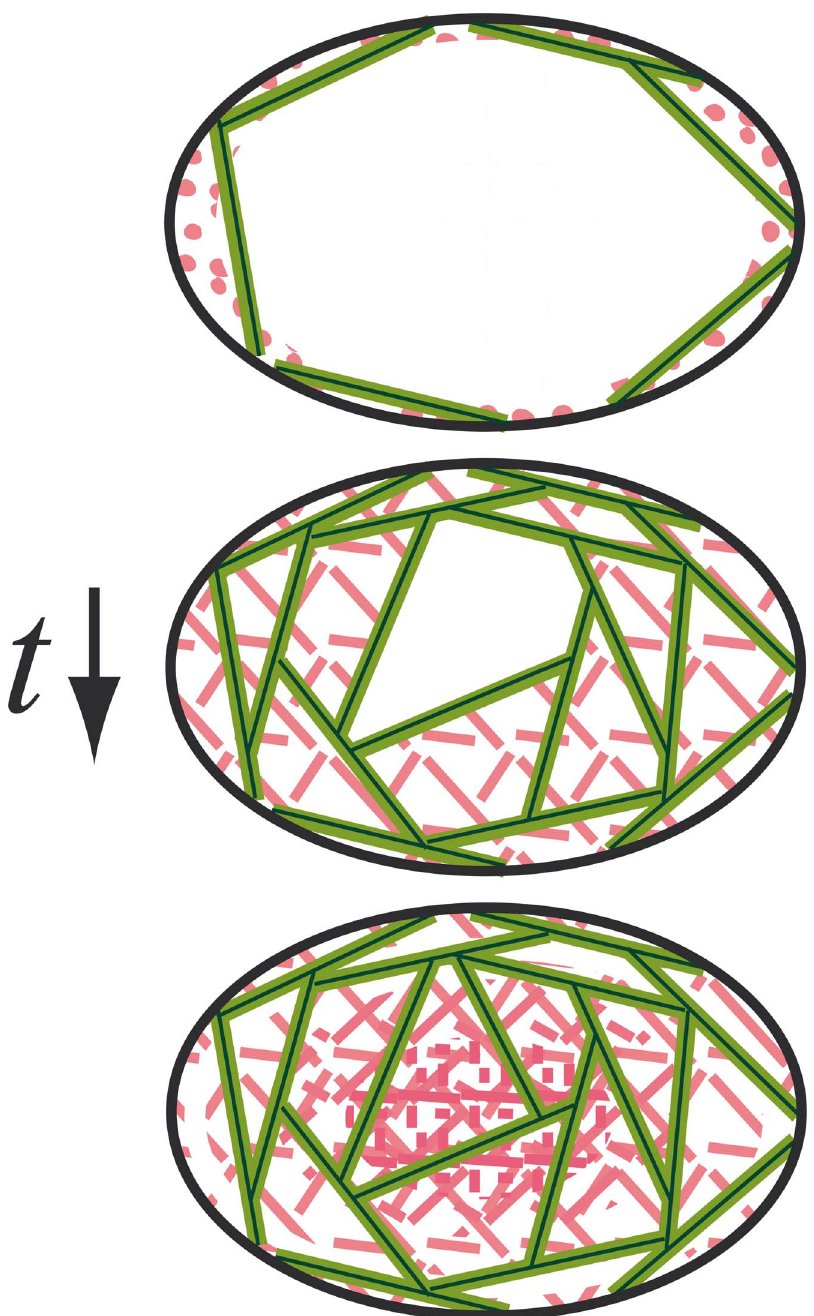
Figure 7. Schematic representation of pore filling as a function of time. Cells are represented by tensioned chords in green and fibronectin is in red. Initially cells are spreading on the pore wall and fibronectin is being produced but not visible as a connected network yet by the cells (top). The pore is subsequently filled by cells with time according to the model and produce fibronectin fibers being unfolded due to cell forces (middle). Finally the pore closes completely and at the same time fibronectin is further compacted towards the center (bottom).